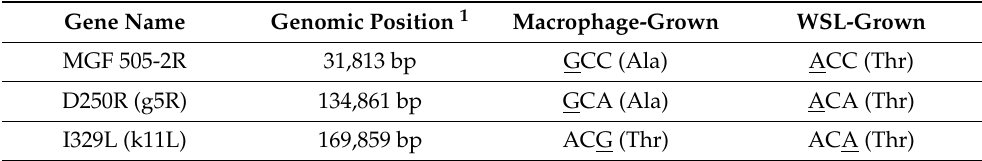
Figure 4. Gross pathology of ASFV-inoculated pigs. Organs from two pigs of each group are shown as examples. ( A , B ) Pigs were inoculated with 10 2 TCID 50 ASFV-Kenya-IX-1033, grown in WSL, or ( C , D ) 10 2 HAD 50 ASFV-Kenya- IX-1033, grown in blood macrophages. From left to right are displayed the spleen, lung, kidneys, stomach mucosa, mesenteric and gastro hepatic lymph node, and liver. Table 1. Single-nucleotide polymorphisms (SNPs) (underlined) between the blood. Macrophage- and WSL-grown viruses that were present in the coding